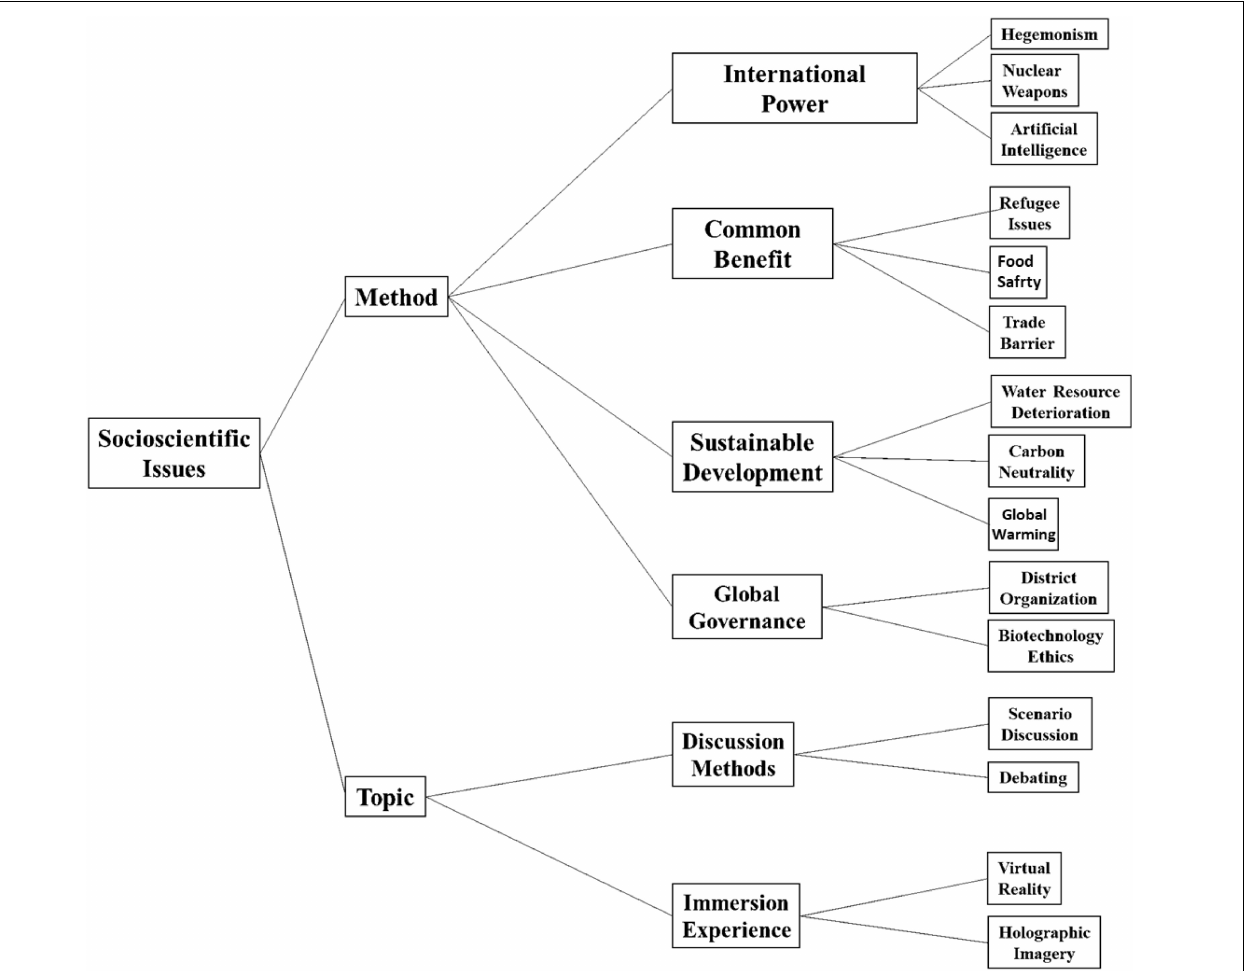
FIGURE 1 | Hierarchy of socioscientific issues (SSI) educational assessment.